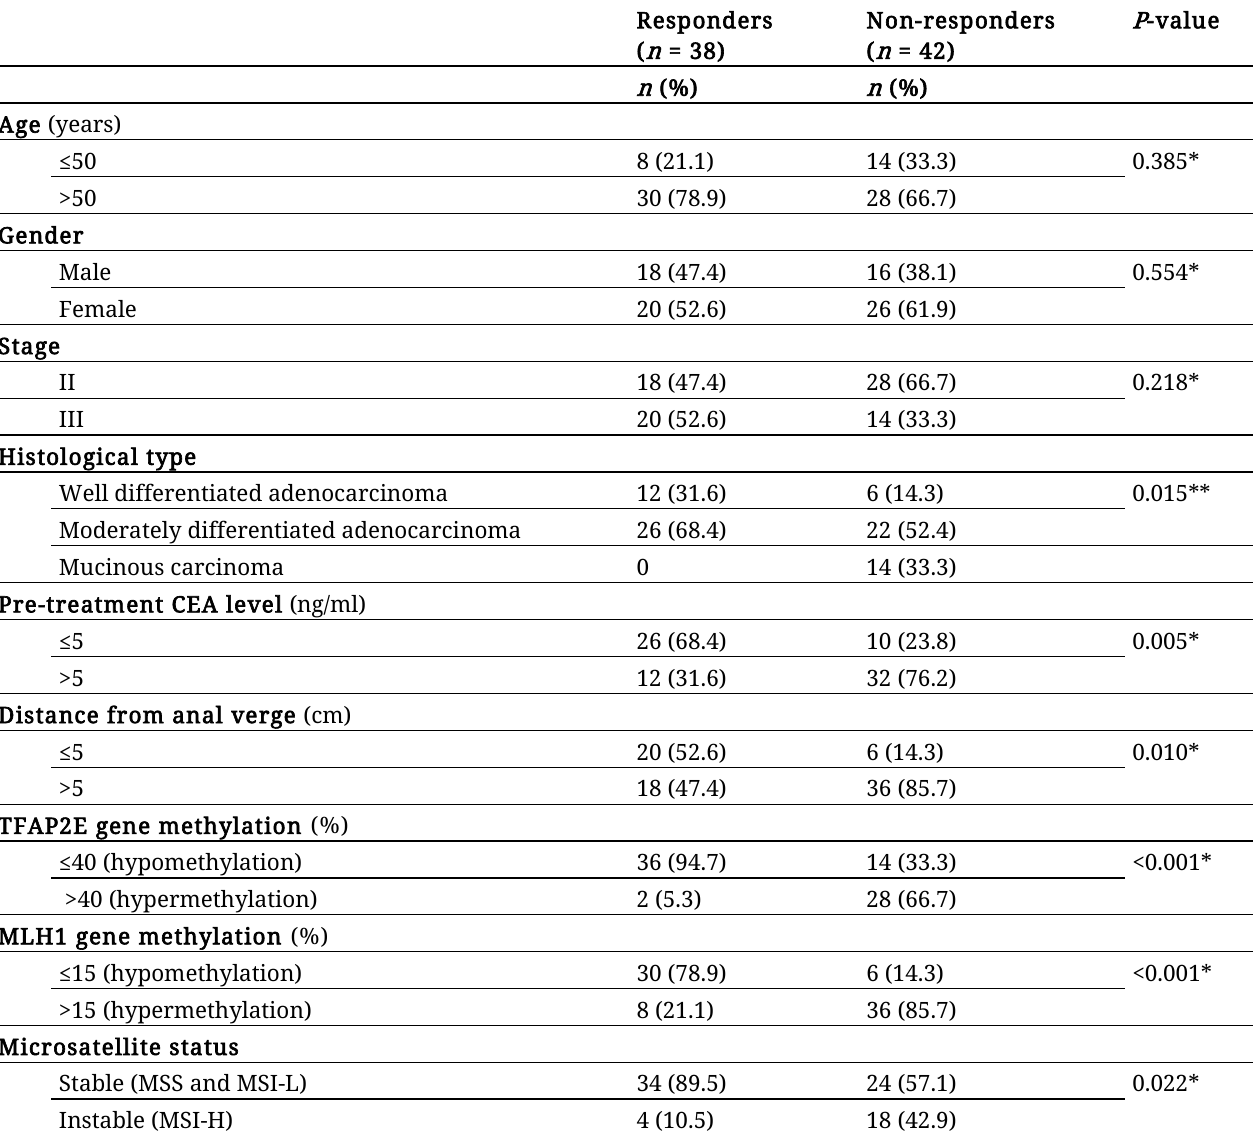
Table 1: Relation between clinico-pathological data and pathological response of rectal cancer to neoadjuvant